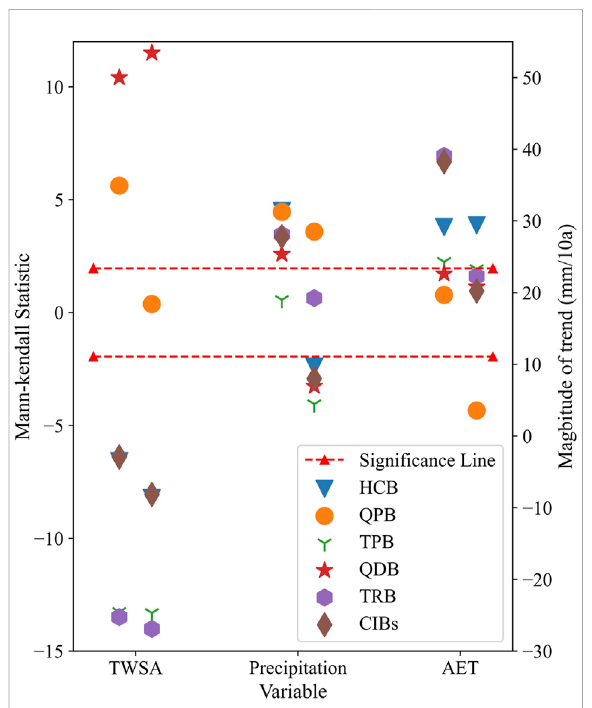
FIGURE 8 Signi fi cance (left) and trend (right) of total water storage anomaly (TWSA), precipitation and actual evapotranspiration (AET) M – KintheChineseinlandbasins(CIBs)andeachclosedbasin.The leftsideindicatesthesigni fi cancestatisticobtainedafterM – K calculation, the right side indicates the magnitude of change obtained from M – K calculation. The red dashed line indicates the cut-off line of signi fi cance. TRB, TPB, QDB, QPB, and HCB indicates Tarim Basin, Turpan Basin, Qaidam Basin, Qiangtang Basin, and Hexi Corridor Basin,